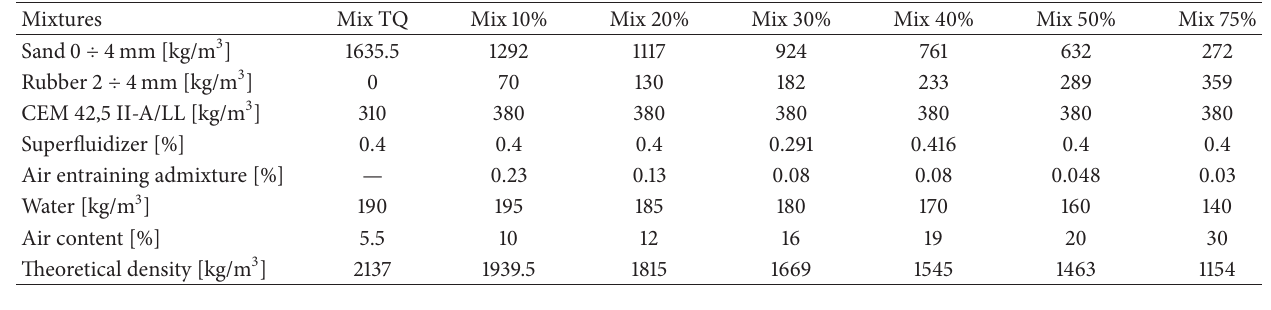
Table 1: Mixtures of cement composites.